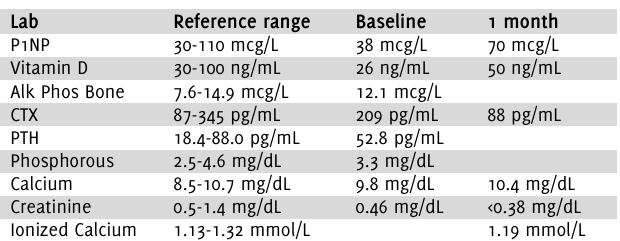
Table 2 . Baseline and post-therapy